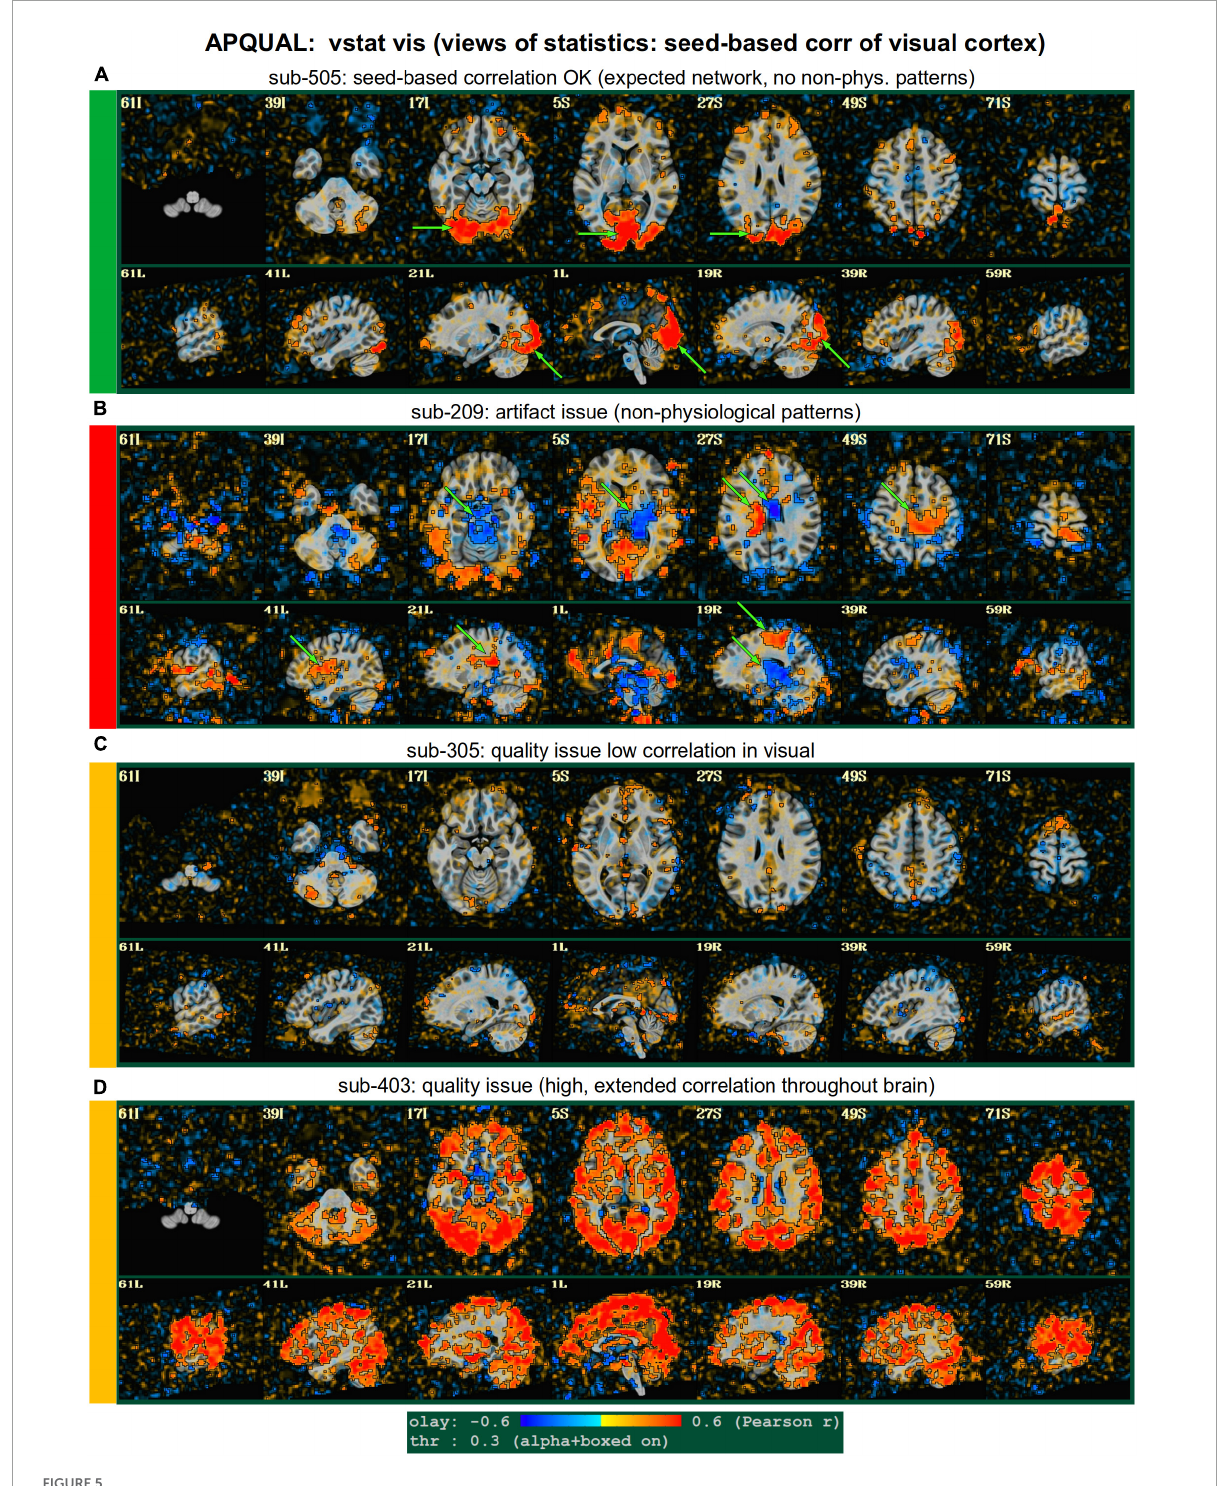
FIGURE5 APQUAL examples for the “vstat” QC block: Visualizations of the statistical information after regression modeling (here, the seed-based correlation map showing the visual network). (A) Expected regions are present, and high correlation regions show network-related spatial specificity (some noise, blurring, and asymmetry are expected). (B) A large, non-physiological region of high correlation is shown, expanding across multiple tissue boundaries, and appears to be artifactual. (C) Almost no intra-network correlation is observed. (D) The high correlation pattern extends far beyond the expected network (to nearly all